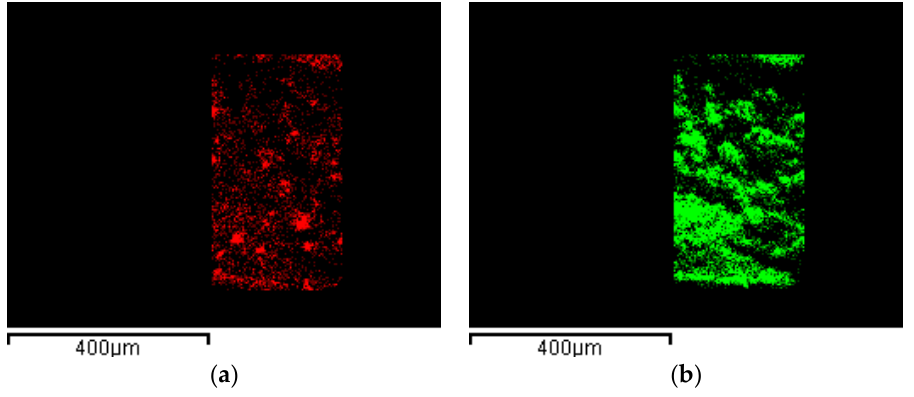
Figure 7. EDX maps of: ( a ) PVDF HFP network identified by C atoms and ( b ) RuO 2 identified by Ru atoms. Porosity of PVDF HFP aerogel alone and of RuO 2 containing nanocomposites was measured as previously [23]. The results reported a PVDF HFP aerogel porosity of 78.5% that increased with RuO 2 content from about 80%, at 10% NPs loading, up to the maximum value of 88.2%, when RuO 2 loading was 60% w / w , in agreement with the morphological study (Figure 6c). N 2 adsorption-desorption allowed to obtain the RuO 2 based-electrode surface area that resulted equal to 66 m 2 /g for PVDF HFP_RuO 2 10 and to 61 m 2 /g for PVDF HFP_RuO 2